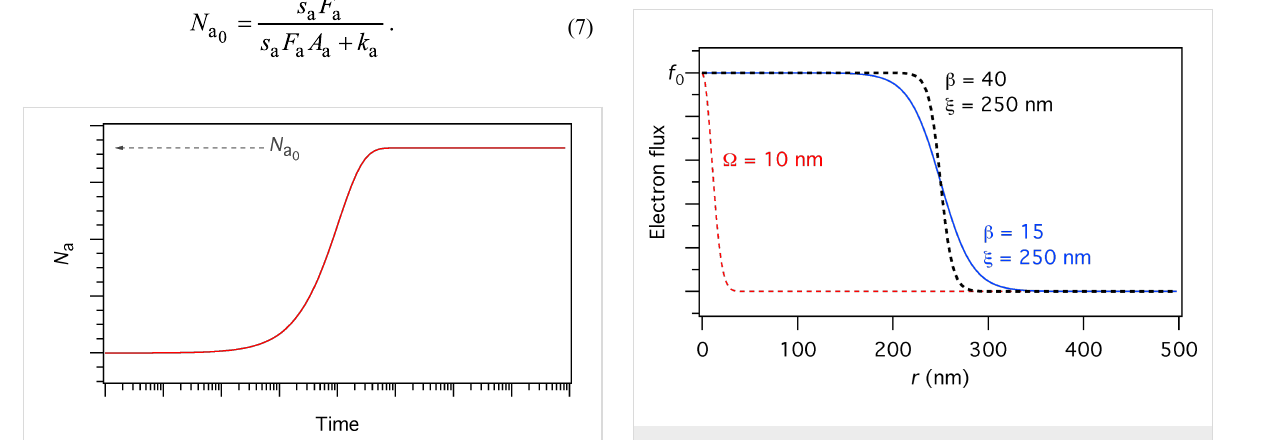
Figure 4: Gaussian electron flux profile ( Ω = 10 nm) and two tophat flux profiles with a radius of 250 nm ( β = 15 and 40). All three profiles are normalized to f 0 , the electron flux at the beam